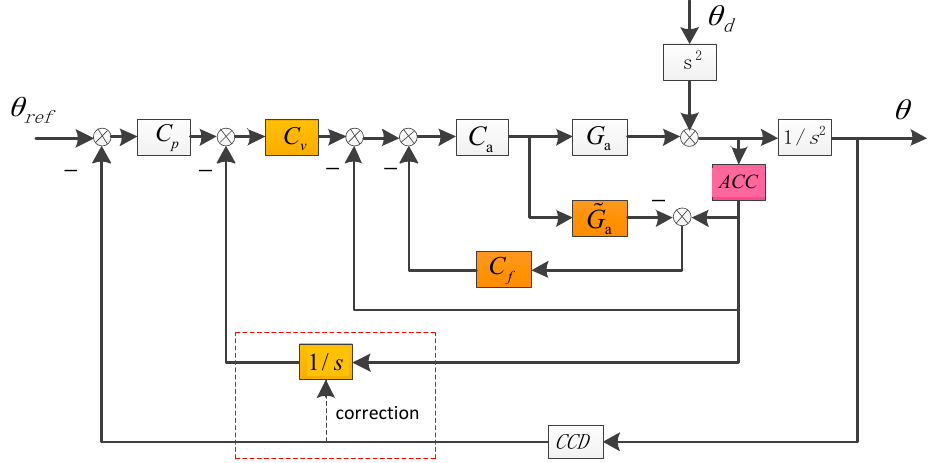
Figure 4. The structure of the TLC with DOB. The velocity is acquired by the acceleration integral and CCD signal would help to correct the velocity. C v is the velocity